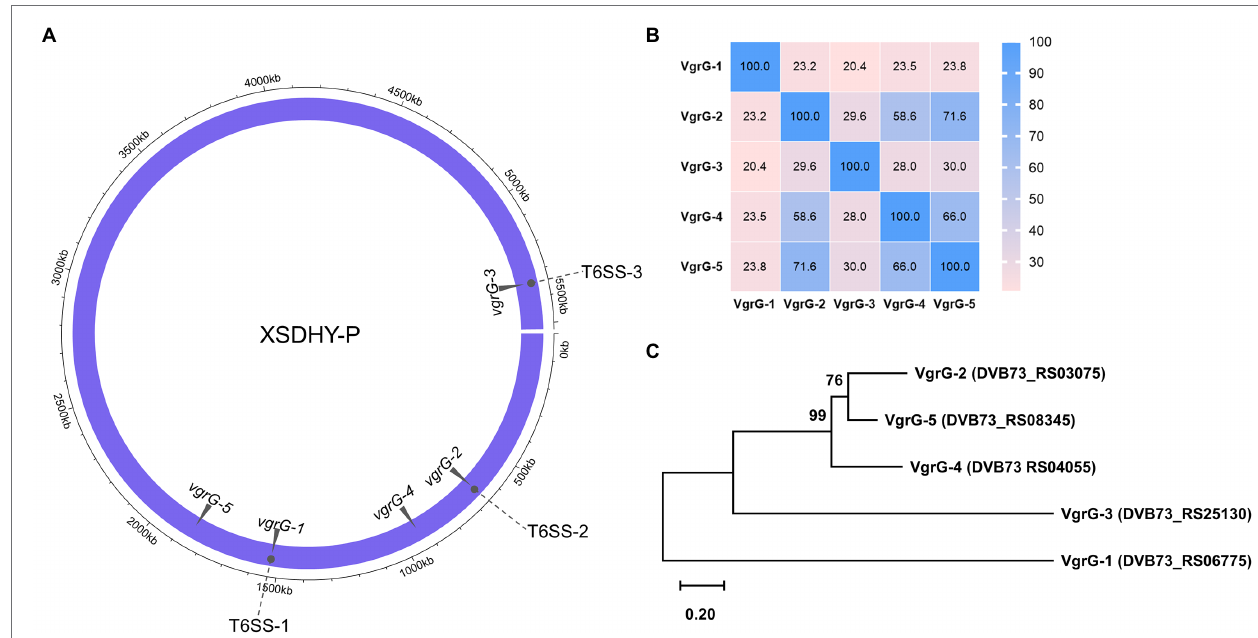
FIGURE 1 | Distribution of the T6SS-1, T6SS-2, and T6SS-3 clusters, and the vgrG genes in the Pseudomonas plecoglossicida strain XSDHY-P (A) . Heatmap showing identity comparison matrix of sequence alignment of VgrG proteins (B) . A color key indicates the correspondence between pairwise identities and the colors displayed in the matrix. Phylogeny of VgrG proteins (C) . Maximum likelihood tree showing the phylogenetic relationship of VgrG proteins in P. plecoglossicida XSDHY-P strain. Bootstrap n = 1,000 constructed based on ClustalOmega alignment of VgrG amino acid